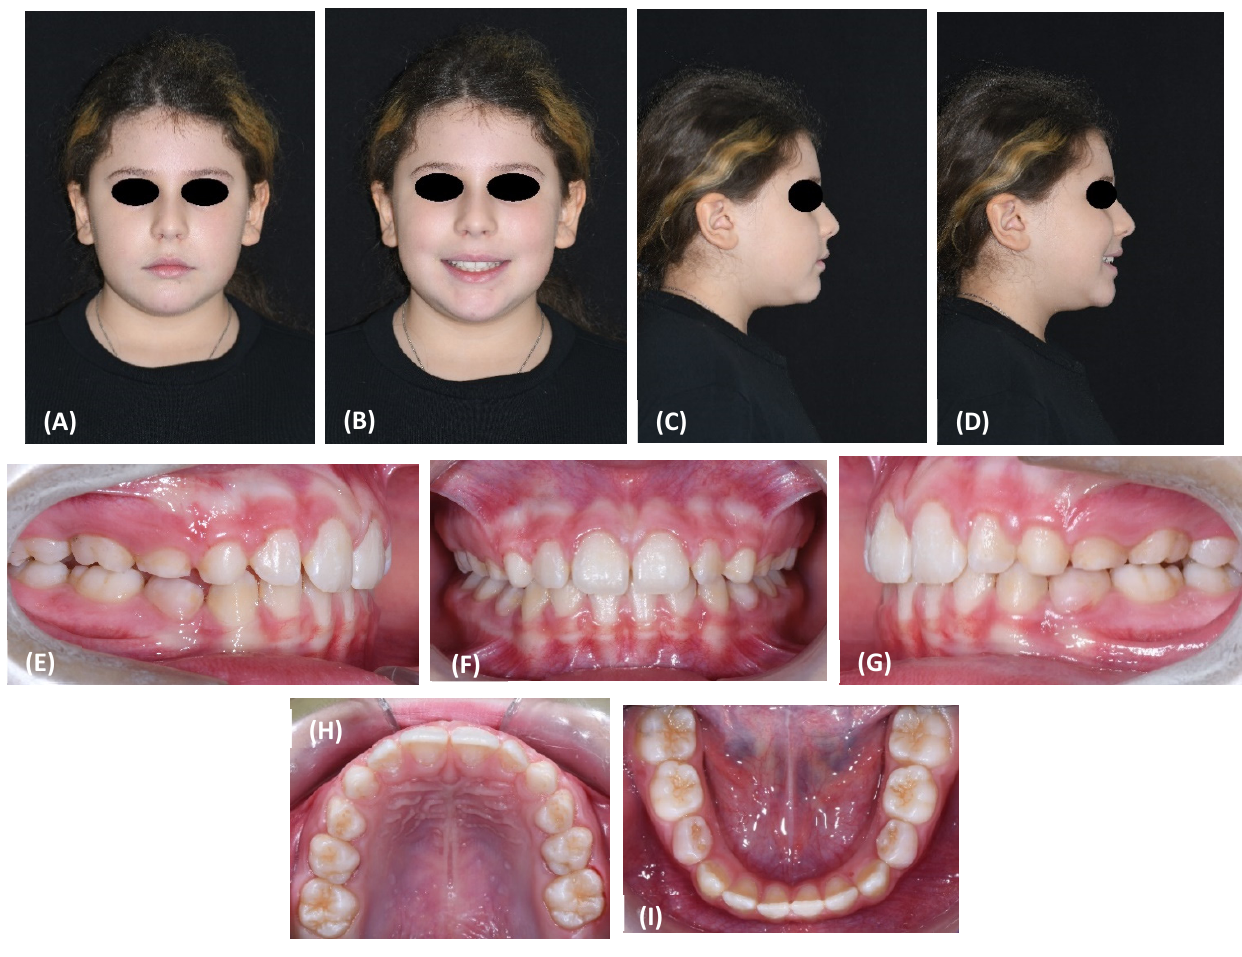
Figure 7. ( A – D ) Posttreatment facial photographs. ( E – G ) Posttreatment intraoral frontal and lateral photographs. ( H , I ) Posttreatment occlusal upper and lower arch photographs.